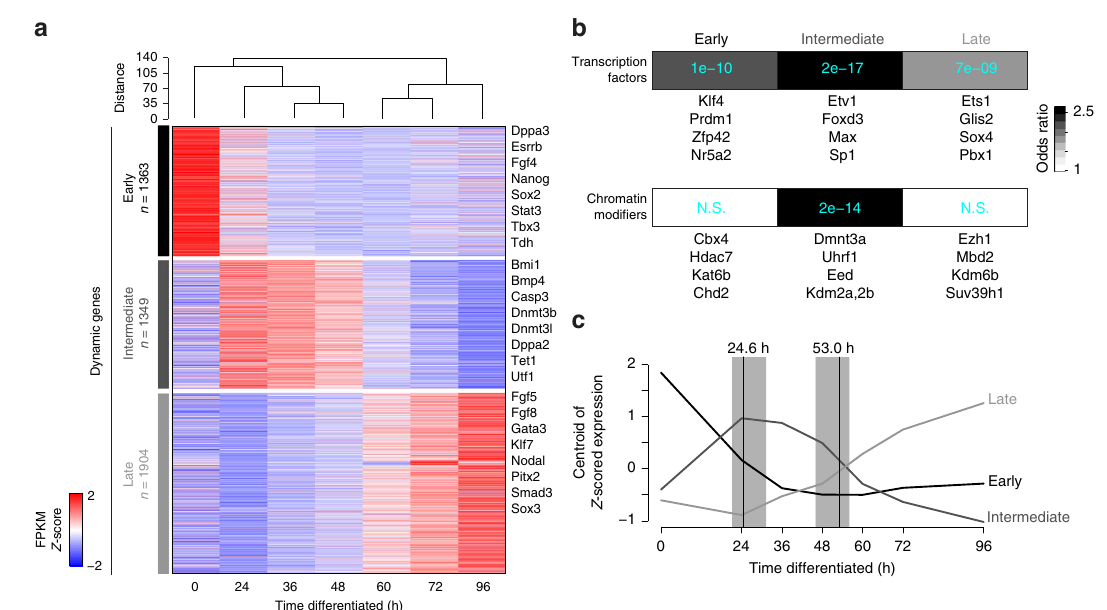
Fig. 3 Transcriptional dynamics during the differentiation time course. a Heatmap of all dynamically expressed genes as measured by RNA-seq (minimum 2-fold change with FDR < 0.05 between any two timepoints; FPKM ≥ 1; n = 4,616) and clustered by k-means into three major categories: early (rapidly lost/decreasing), intermediate (transiently upregulated), or late (increasing or induced over time). Hierarchical clustering of the samples by Pearson correlation (top) separates iPSC/early differentiation timepoints and populations differentiated for longer than 48 h. Select genes belonging to each major expression dynamic category are listed on the right. Each timepoint consists of two replicates. b Enrichment for the three dynamic classes within a set of all annotated transcription factors (top row) or chromatin modi fi ers (bottom row). Greyscale represents enrichment odds ratios, while calculated P values (Fisher ’ s exact test) are indicated in light blue text. Representative members of each set that are not already listed in panel a are listed underneath each tile. c Line plot indicating the centroid of Z scored FPKM expression values for the three separate expression dynamics (early, intermediate, and late), demonstrating the overall transcription trajectory for each group over differentiation time. For reference, the range of state transition times calculated in Fig. 1d are highlighted with grey bars, with the median of transition times indicated by vertical black